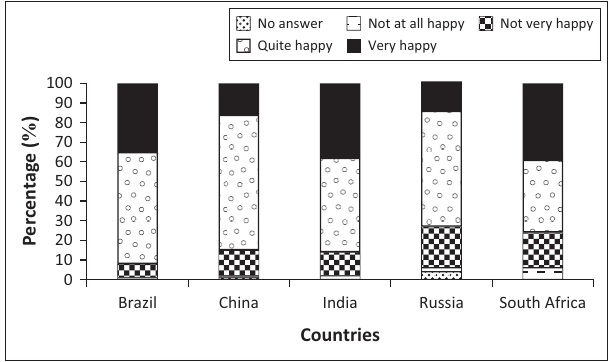
FIGURE 1: Brazil, Russia, India, China and South Africa countries’ levels of happiness, 2010–2014.